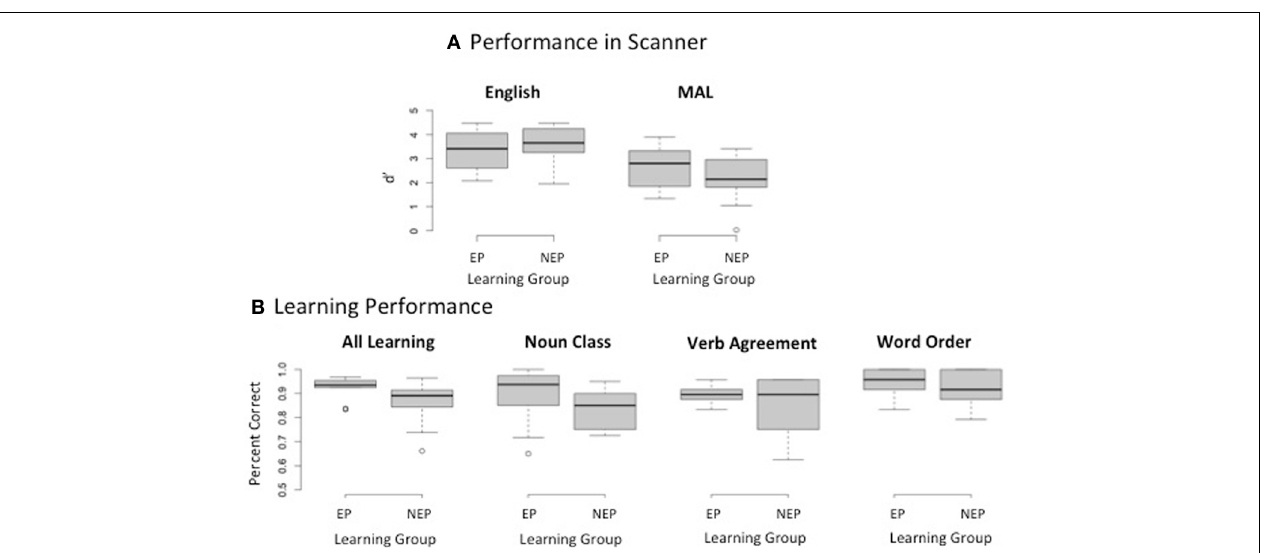
FIGURE 2 | Behavioral Performance. Box plots depict the median (middle line), upper quartile (top of box), lower quartile (bottom of box), maximum value (top whisker, excluding outliers), and minimum value (bottom whisker, excluding outliers); outliers are depicted as circles. Discrimination sensitivity (d’) does not differ for making grammaticality order) (B)